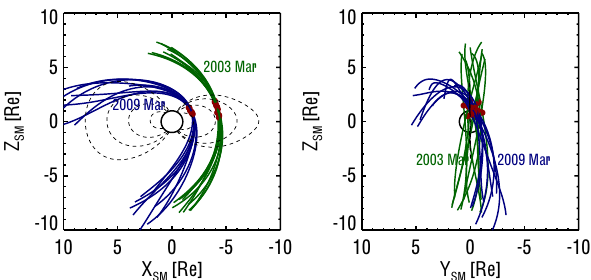
Fig. 1. Example of successive perigee passes by C2 for March 2003 (green) and March 2009 (blue) projected in SM coordinates. Dashed black lines draw magnetic field lines estimated by the geomagnetic model IGRF-11+Tsy04. Red dots are placed at the perigees of the plotted